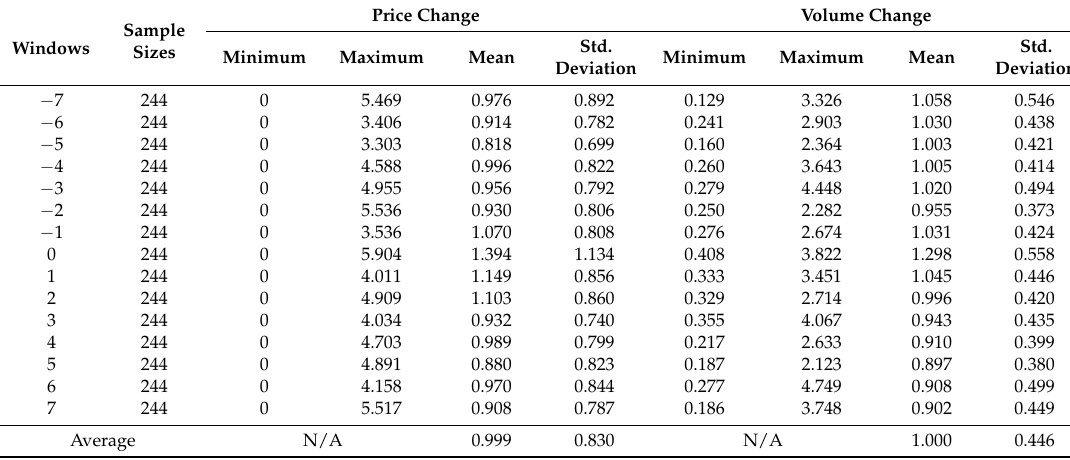
Table 2. Summary information of